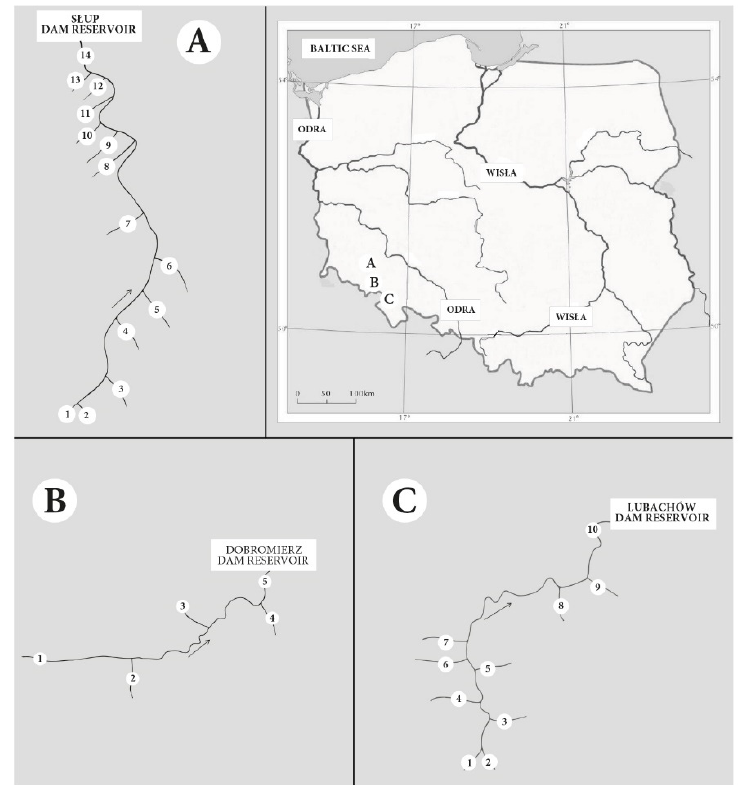
Figure 1. Location of the study area: ( A ) Słup reservoir—research sites on the Nysa Szalona River and its tributaries; ( B ) Dobromierz reservoir—research sites on the Strzegomka River and its tributaries; ( C ) Lubachów reservoir—research sites on the Bystrzyca River and its tributaries.